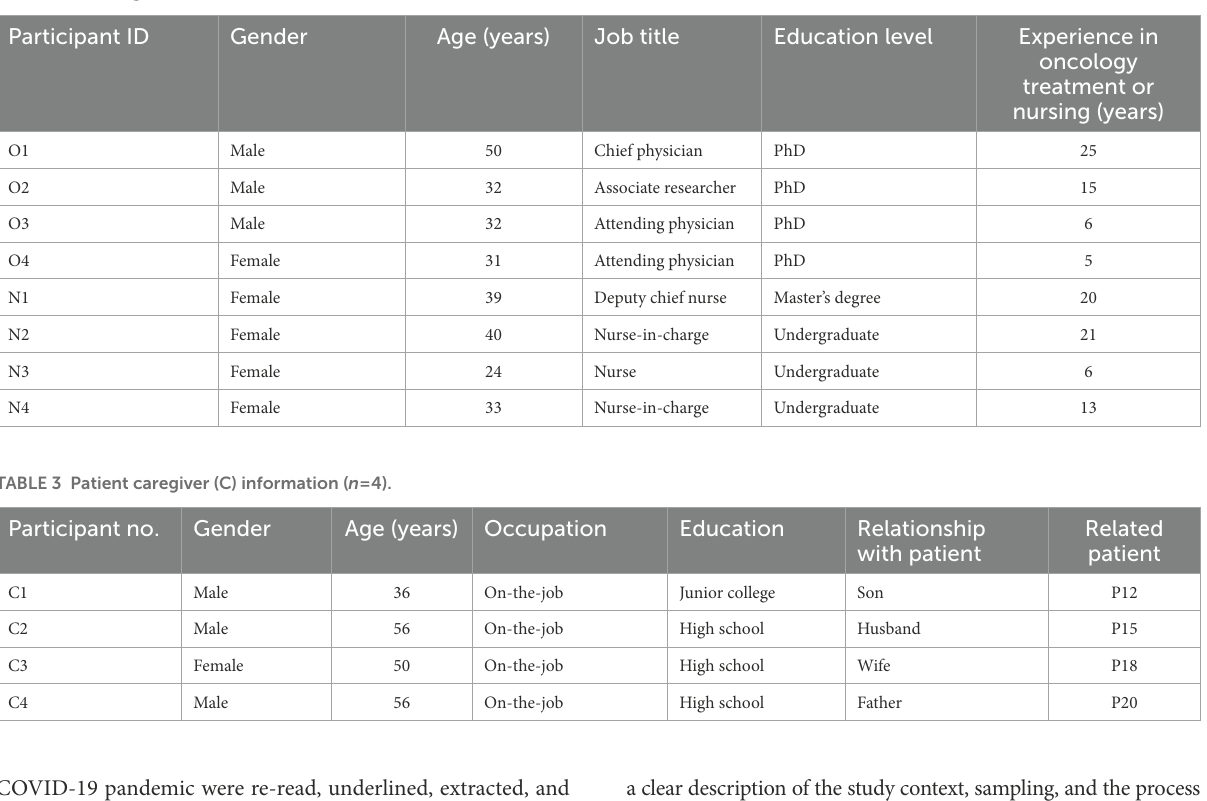
TABLE 2 Oncologist (O) and nurse (N) information ( n = 8).